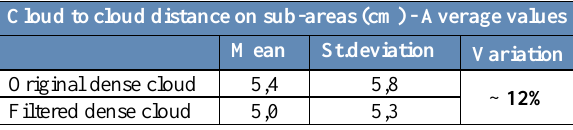
Figure 9: The areas where the plane fitting analyses were performed. Cloud to cloud distance on sub-areas (cm) - Average values